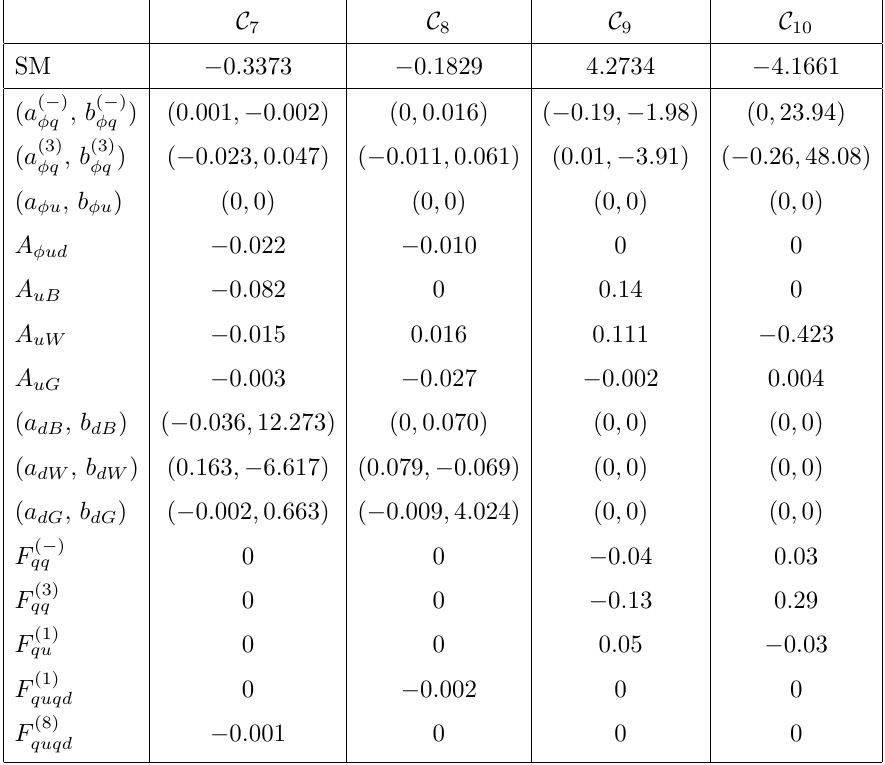
at LO in QCD. The b and C are not generated by 9 0 10 0